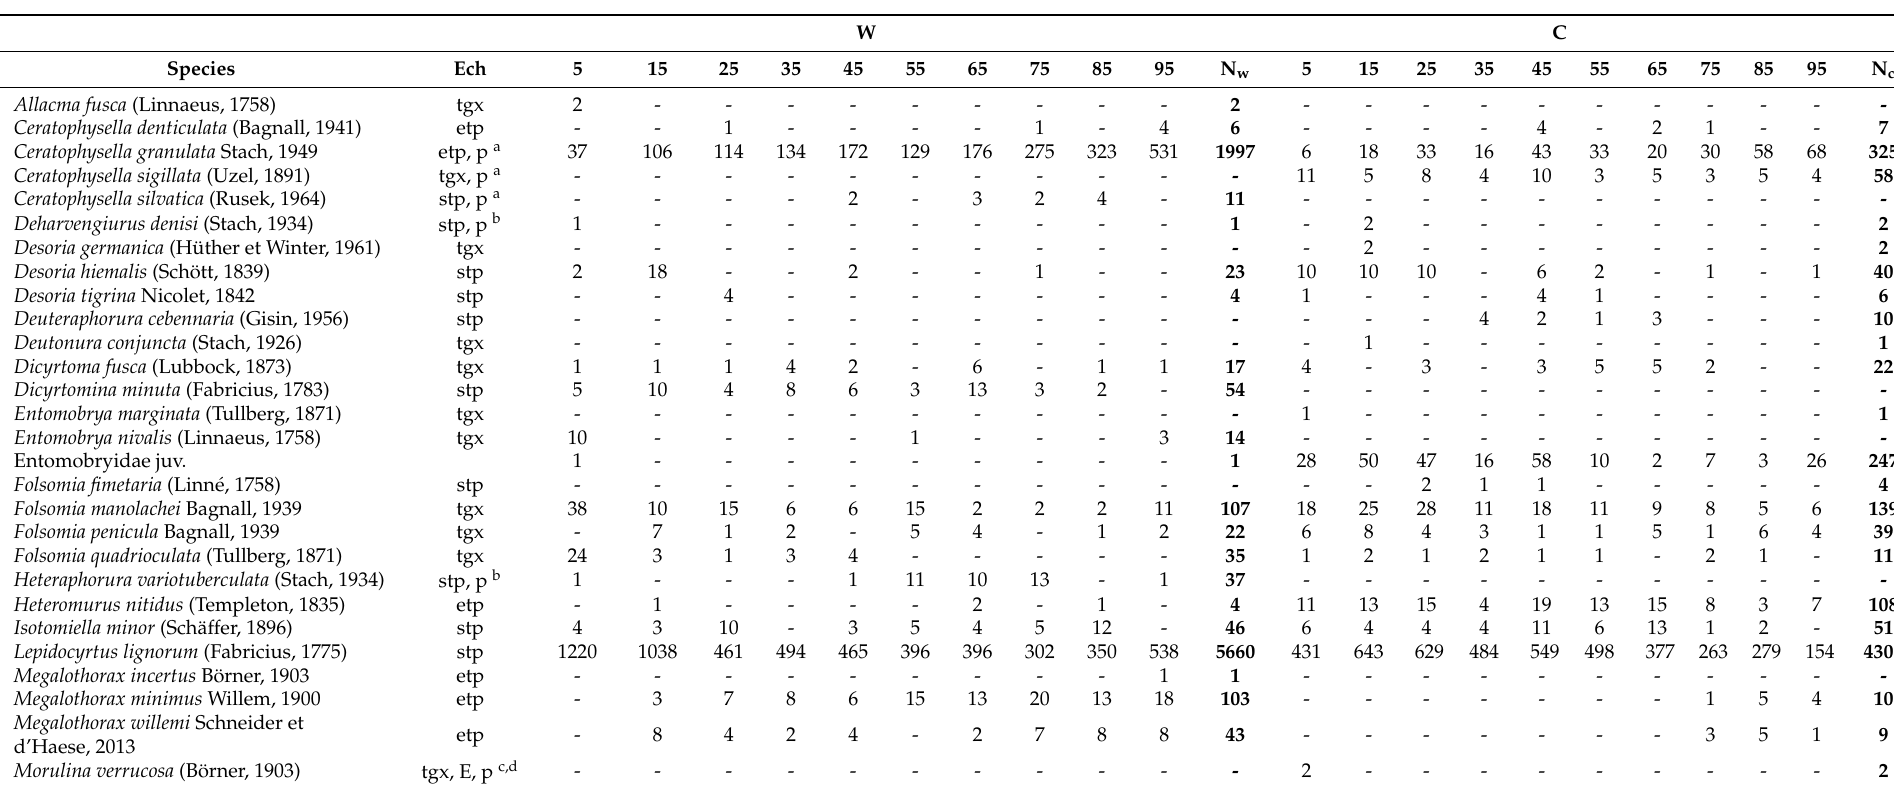
Table A1. Ecological characteristics of Collembola species and their abundances in vertical profile of 5–95 cm at the base of the scree slope (site SA) in warm and cold